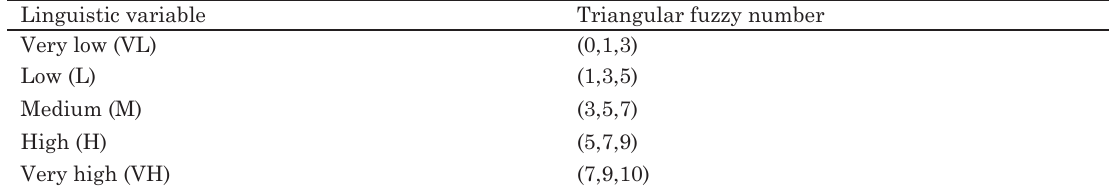
table 3. Definition and membership function of fuzzy